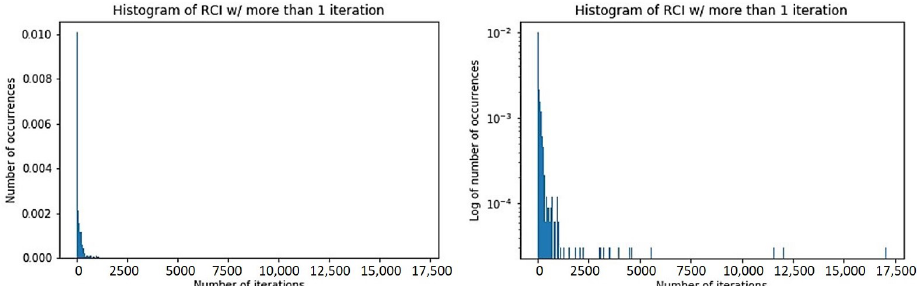
Figure 9. Histogram of the number of iterations for the convergence of each RCI process that needed more than one iteration to find a solution. ( Left ): Linear scale. ( Right ): Logarithmic